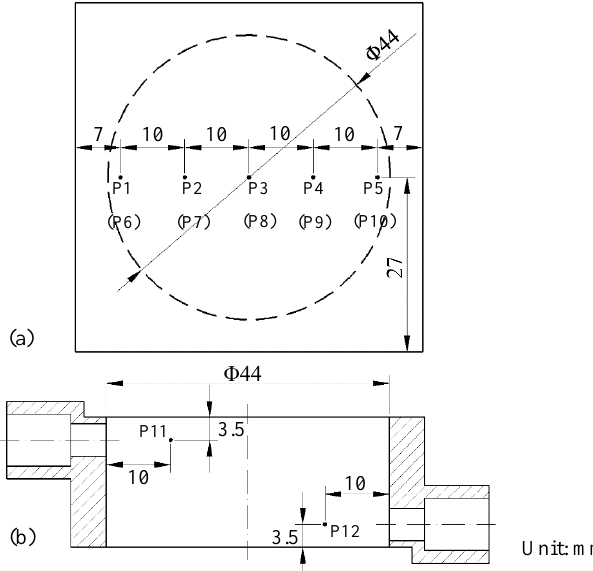
Figure 2. Structure of vapor chamber with side window.